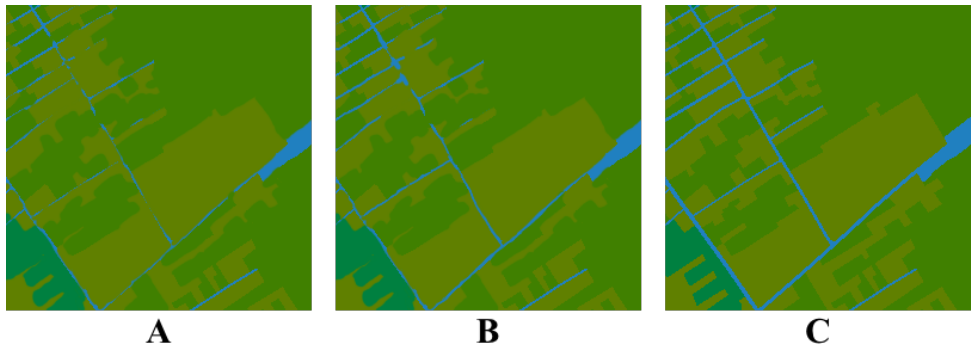
Figure 12. Comparison of segmentation image continuity. ( A ) is the segmented image without morphology module processing; ( B ) is the processed image; ( C ) is the ground truth.